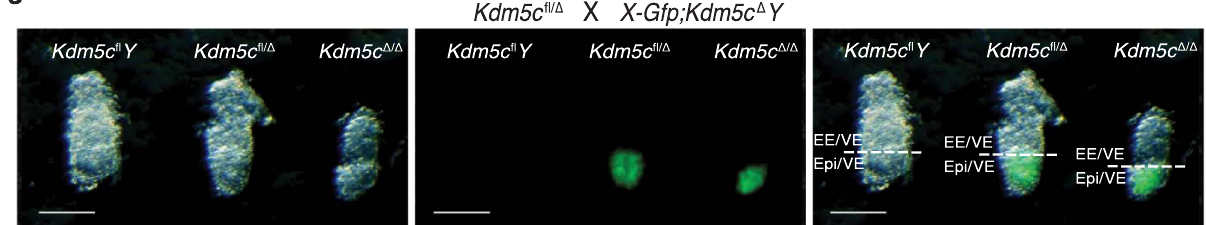
Fig. 1 Lethality of Kdm5c Δ / Δ female embryos. a , b Relative quanti fi cation of Kdm5c RNA levels in wild-type XX female and XY male EpiSCs ( a ) and ESCs ( b ) by RT-qPCR. Each bar in the graph represents an individual cell line analyzed by RT-qPCR in triplicate. Data are presented as mean ± standard deviation between technical replicates. c – f Quanti fi cation of liveborn mice ( c – e ) and recovery of embryonic day ( E ) 5.5 and 6.5 embryos ( f ). g Representative micrographs of E5.5 embryos. 13 litters were analyzed with similar results. Scale bars, 50 μ m. Expression of a paternally-inherited X-Gfp transgene marks female embryonic epiblasts (Epi) but not extraembryonic ectoderm (EE) or visceral endoderm (VE) due to random X-inactivation in the epiblast lineage and imprinted X-inactivation of the paternal X-chromosome in extraembryonic lineages 60,61 . See also Supplementary Fig. 1a. Source data are provided as a Source Data fi